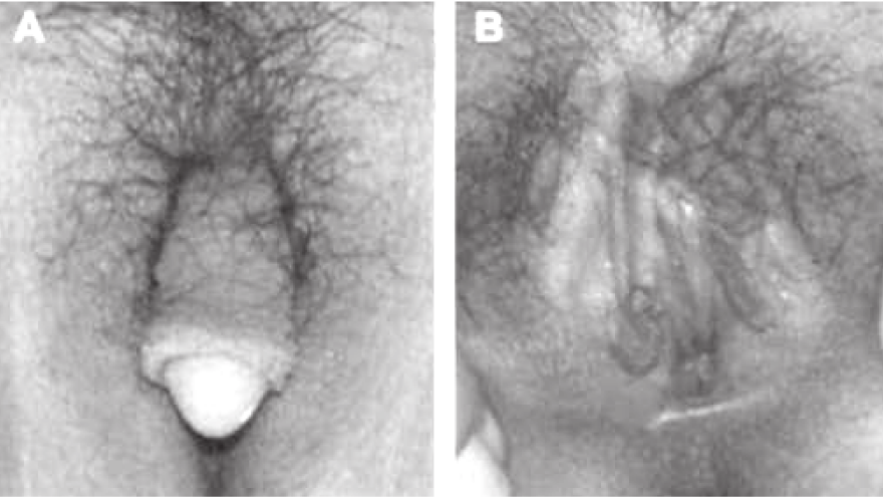
Figure 2 - External genitalia of patient with congenital adrenal hyperplasia before (A) and after (B) genitoplasty - cosmetic result classified as good